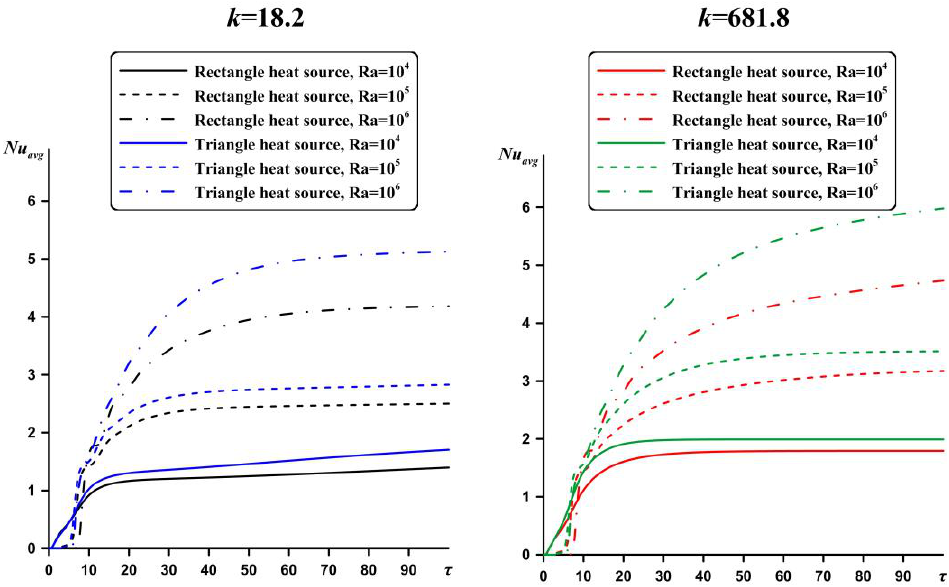
Figure 10. Time profiles of the average Nusselt number at the vertical wall depending on the heat source shape, k and Ra.